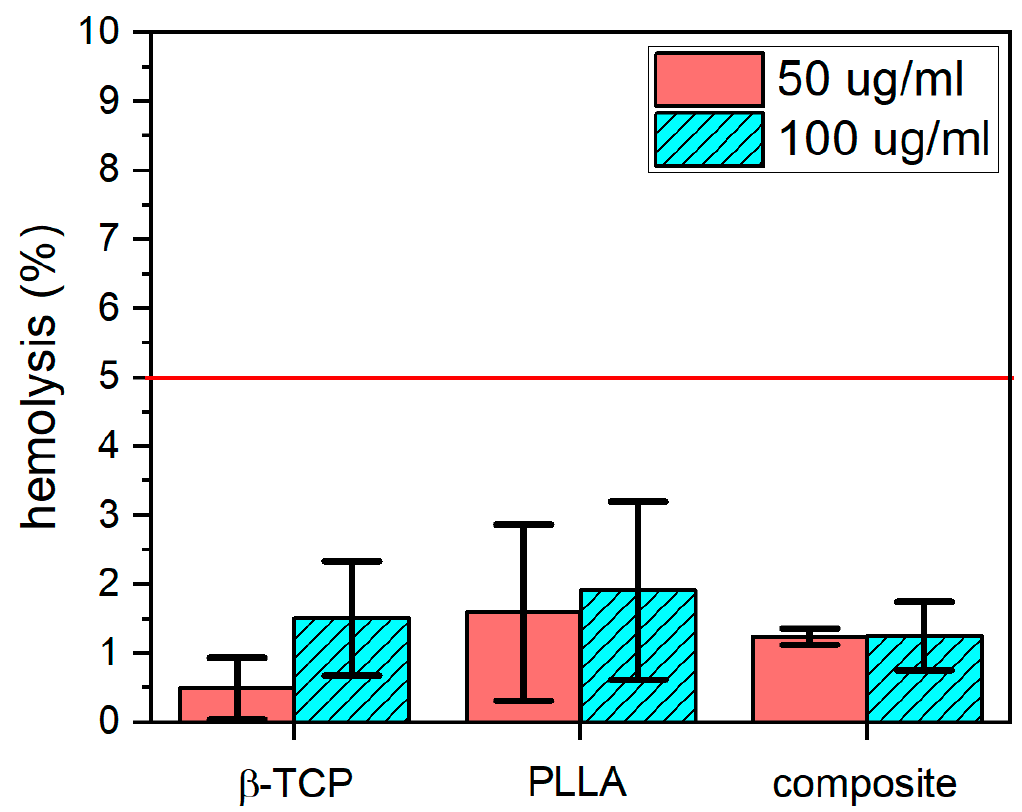
Figure 8. Activity of β -TCP co-doped with Ce 3+ and Pr 3+ ions, PLLA, and PLLA with β -TCP composite with phosphate:polymer 1:20 ratio, in concentrations 50 µg/mL and 100 µg/mL in reference to 1% of SDS solution (mean ± SD, n = 3; all results were statistically significant). The red line indicates the acceptable hemolysis level.